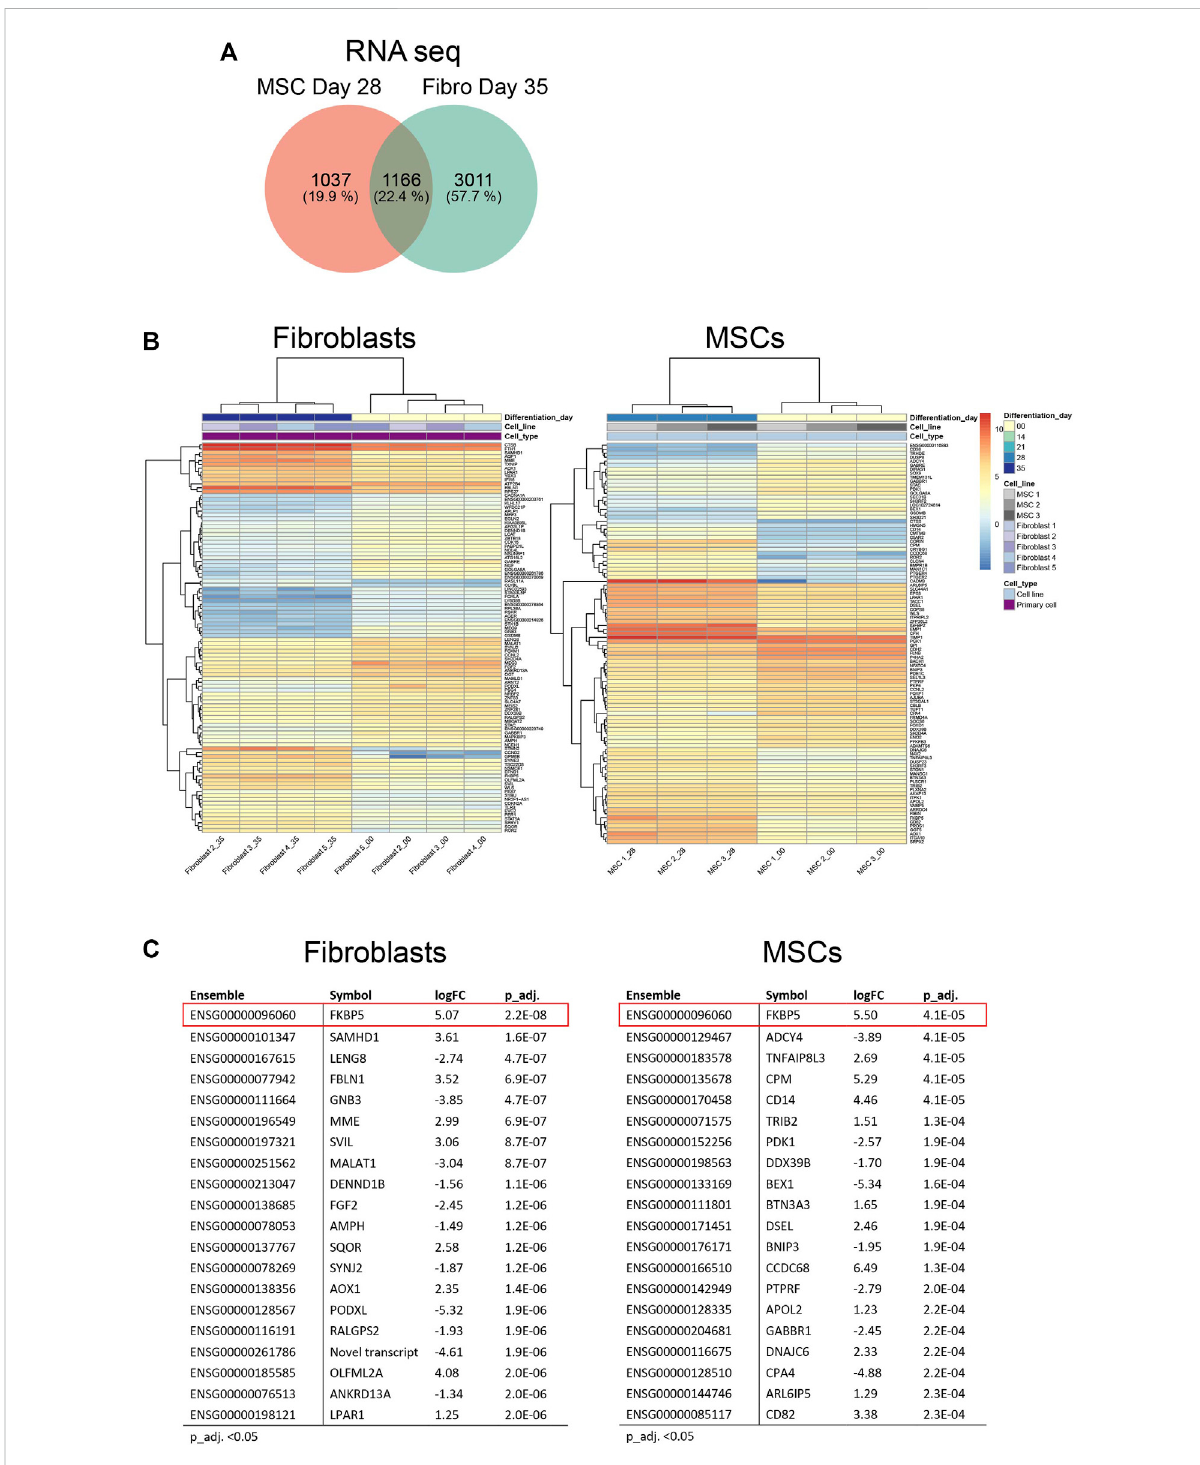
FIGURE 4 Differential gene expression in fi broblasts and MSCs at endpoint. (A) Venn diagram comparing total number of differentially expressed genes in fi broblasts and MSCs, undifferentiated state (Day 0) versus differentiated state (Day 35 in fi broblasts/Day 28 in MSCs). In both cell types, 1,166 genes were included, 1,037 genes were exclusively expressed in MSCs while 3,011 genes were exclusively expressed in fi broblasts. (B) Top 100 and (C) Top 20 differentially expressed genes in MSCs and fi broblasts comparing undifferentiated state to last time point. FKBP5, highlighted in red, was differentially expressed in both cell